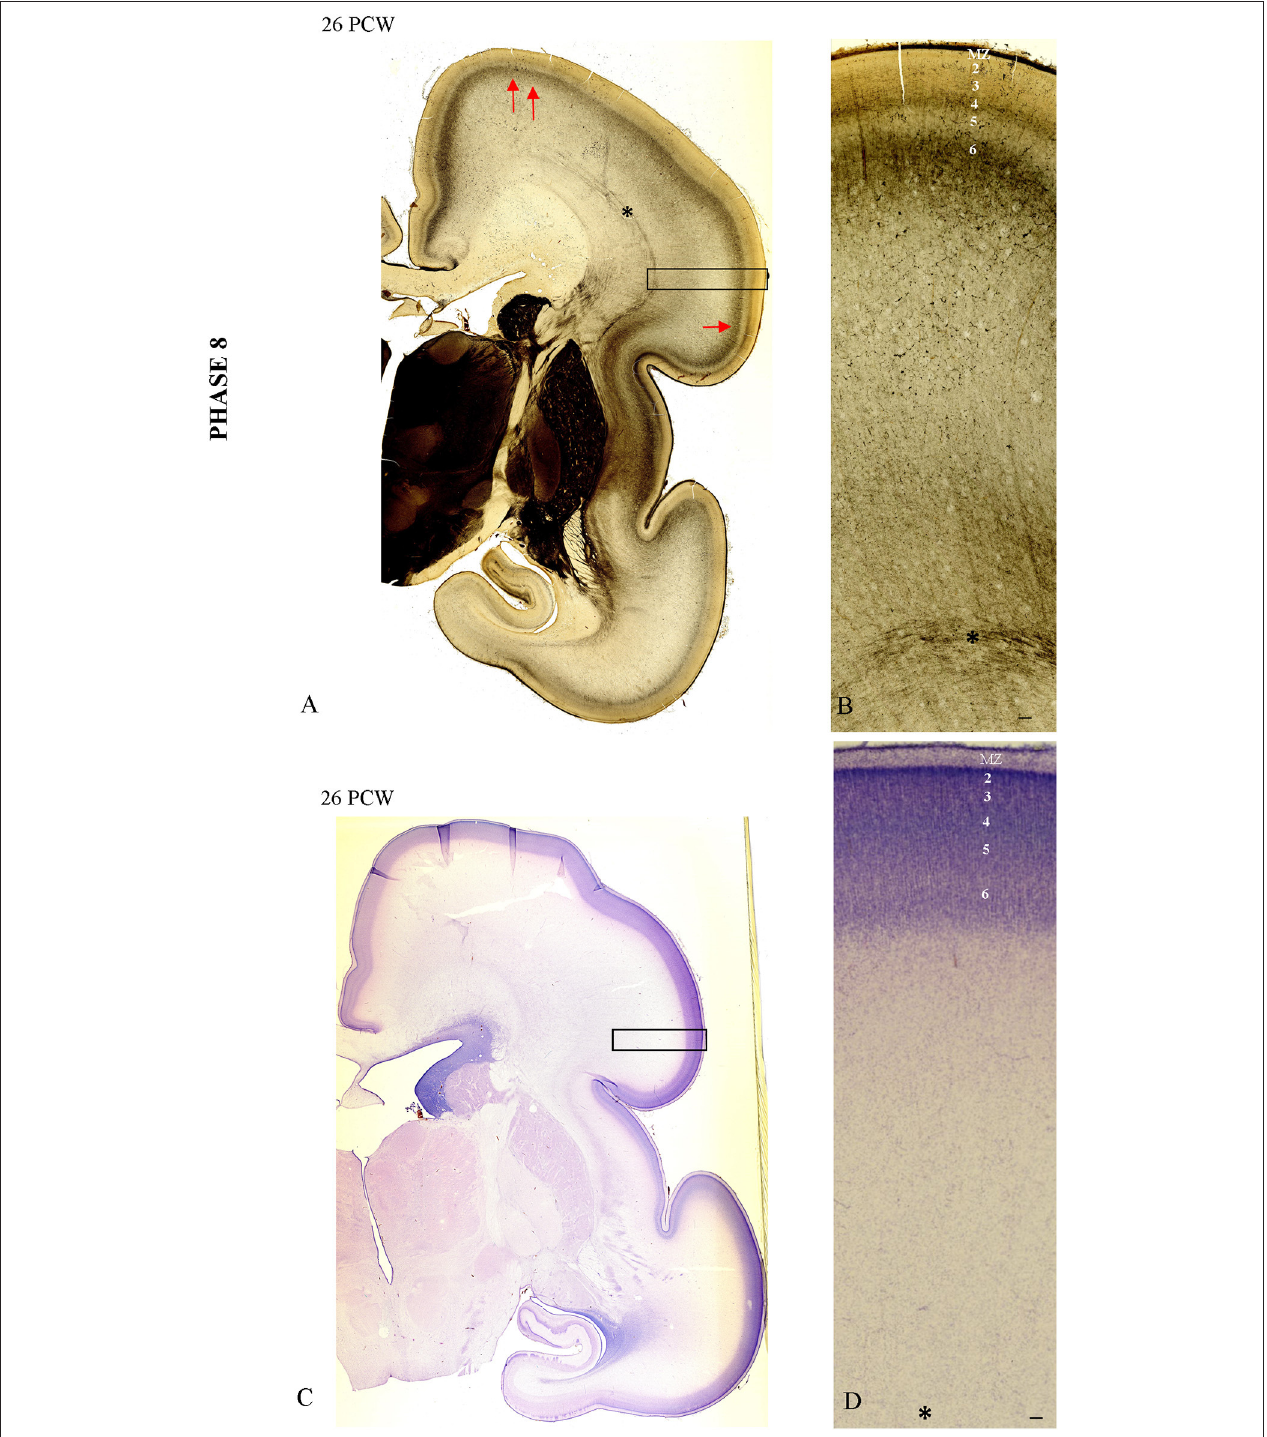
FIGURE 7 | The AChE patterned lamination in the “ventral” somatosensory cortex (arrow) precedes the AChE lamination in the dorsal cortex (double arrow, A). In the “ventral” somatosensory cortex at 26 PCW reactivity is trilaminar (CP AChE-positive band, CP AChE-negative band and superficial SP AChE-positive band), shown on (B) . Adjacent Nissl stained section with prospective cortical layers (C,D) . Asterisk marks border between SP and fiber strata of intermediate zone (fetal white matter). Scale bar: 100 µ m.